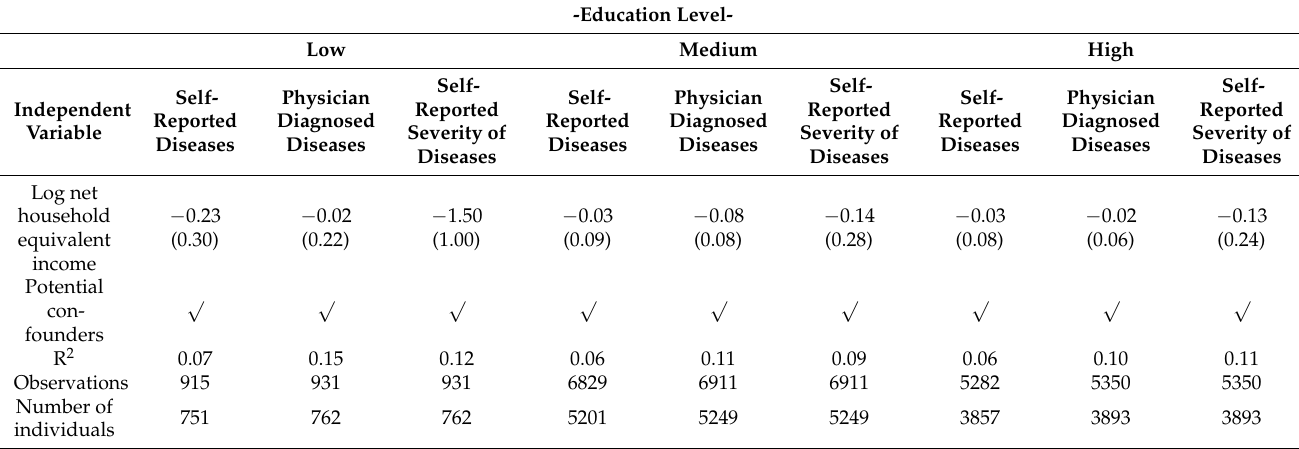
Table 5. Determinants of morbidity. Results of linear fixed-effects regressions (stratified by education level).